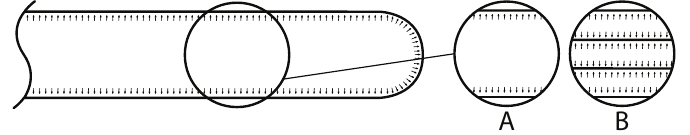
Figure 5. Pressure-based structure: ( A ) pneumatic structure made of a single chamber; ( B ) flexible fluidic matrix composite made of several chambers in contact with each other. The arrows represent the pressure acting in the structural